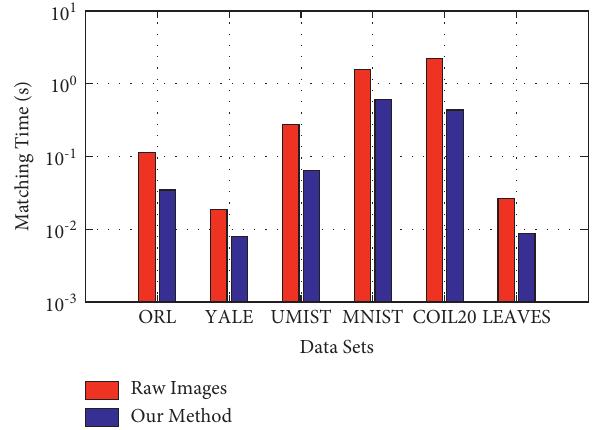
Figure 3: Matching time of the raw image vs matching time of our